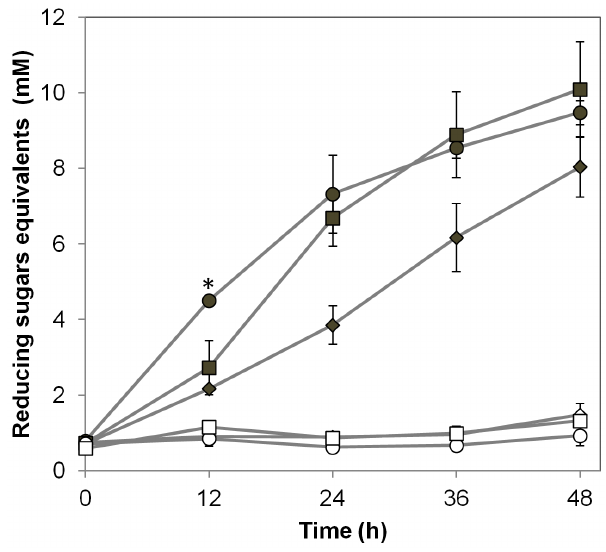
Figure 6. Hydrolytic enzymes (cellulase and xylanase) activity is not influenced by the presence of PcExl1. Endoglucanase from T. reesei (open symbols) was incubated with: buffer only (open diamonds); 150 m g/ml PcExl1 (open circles); and 150 m g/ml BSA (open squares). Endoxylanase from T. logibrachiatum was incubated with: buffer only (full diamonds); 150 m g/ml PcExl1 (full circles); and 150 m g/ ml BSA (full squares). All reactions were carried out in 600 m l and agitated at 600 rpm at 30 u C. Samples were taken every 12 h and reducing sugars were quantified by the DNS method, and compared to glucose or xylose standard curves. Reducing sugars concentration is expressed as glucose or xylose equivalents for reactions with cellulase or xylanase, respectively. Results are the arithmetic mean and standard deviations of three independent experiments. *Significant difference between reactions containing Exl1 + xylanase compared to the reactions containing BSA + xylanase, at each time point ( p , 0.05, Fisher’s LSD test).